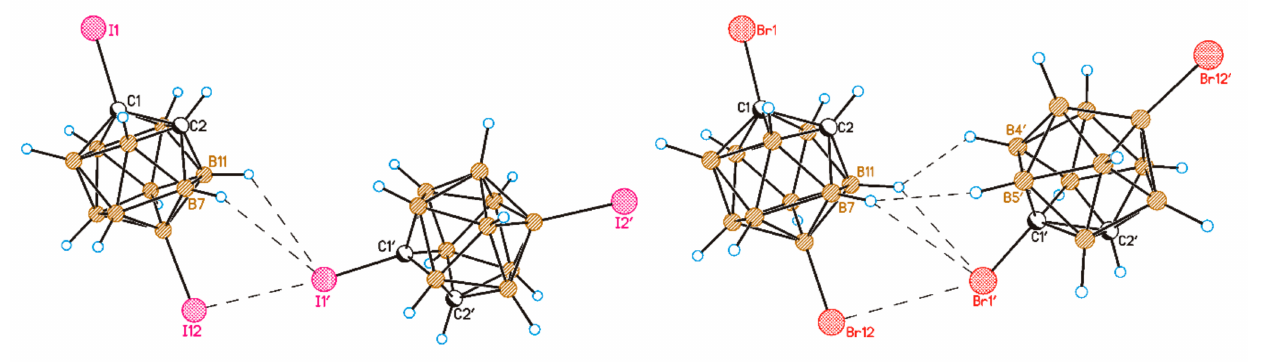
Figure 3. Noncovalent bonding in dimers of 1,12-I 2 -1,2-C 2 B 10 H 10 ( left ) and 1,12-Br 2 -1,2-C 2 B 10 H 10 ( right ). Table 1. Characteristics of intermolecular noncovalent interactions for dimers of 1,12-I 2 -1,2-C 2 B 10 H 10 and 1,12-Br 2 -1,2-C 2 B 10 H 10 . Distance in Å or Angle in